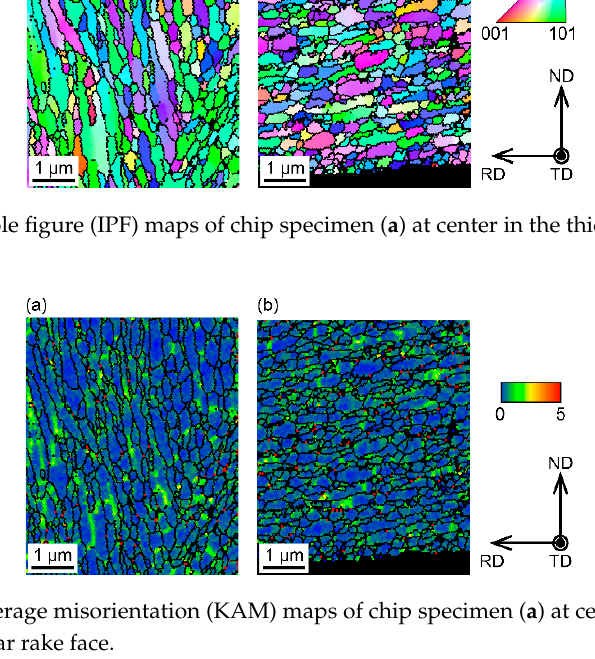
Figure 4. IPF maps of the rolled specimen of ( a ) fine grains and ( b ) coarse grains.